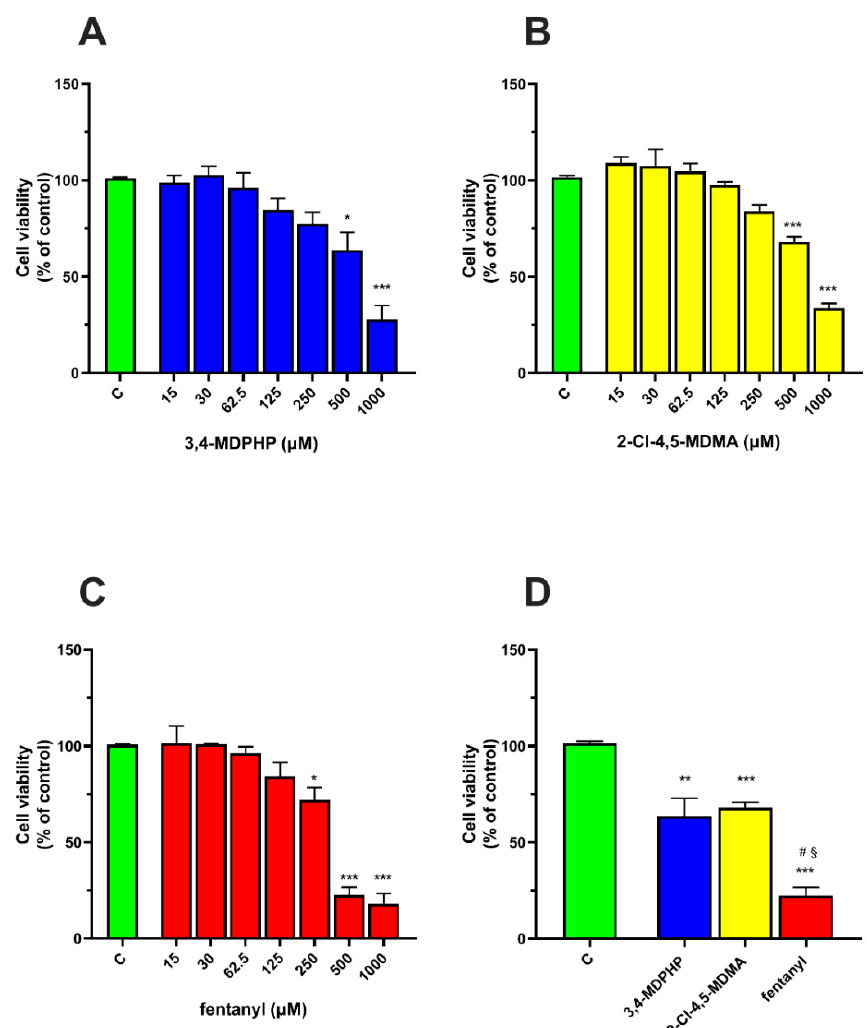
Figure 2. 3,4-MDPHP, 2-Cl-4,5-MDMA, and fentanyl induced cell viability loss in a concentration-dependent manner. Dopaminergic-differentiated SH-SY5Y cells were exposed for 24 h to the different concentrations of 3,4-MDPHP ( A ), 2-Cl-4,5-MDMA ( B ), and fentanyl ( C ), or to 500 µ M of the indicated substance ( D ), and then their viability was measured using the MTT assay. Cell viability was expressed as a percentage of cell viability relative to the control (untreated cells). Data are representative of three independent assays with six replicates for each concentration of the substance used and are presented as mean ± SEM. One-way ANOVA followed by Tukey’s post-hoc. * p < 0.05, ** p < 0.01, *** p < 0.001 compared to respective vehicle-treated control; § p < 0.001 with respect to 2-Cl-4,5-MDMA and # p < 0.01 compared to 3,4-MDPHP.